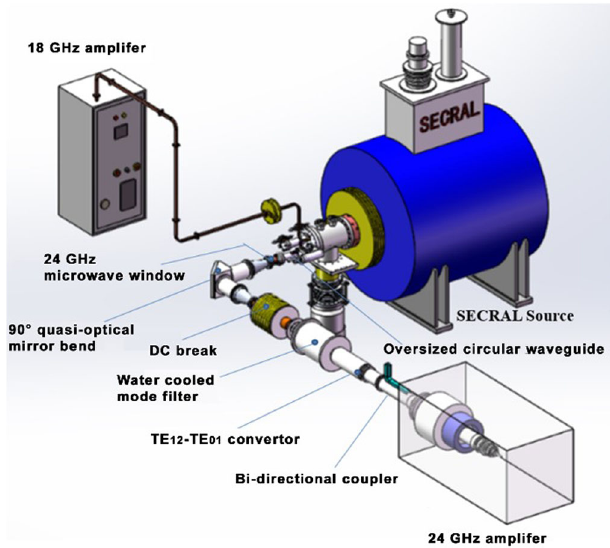
FIG. 11. SECRAL microwave coupling system with 24 þ 18 GHz double frequency